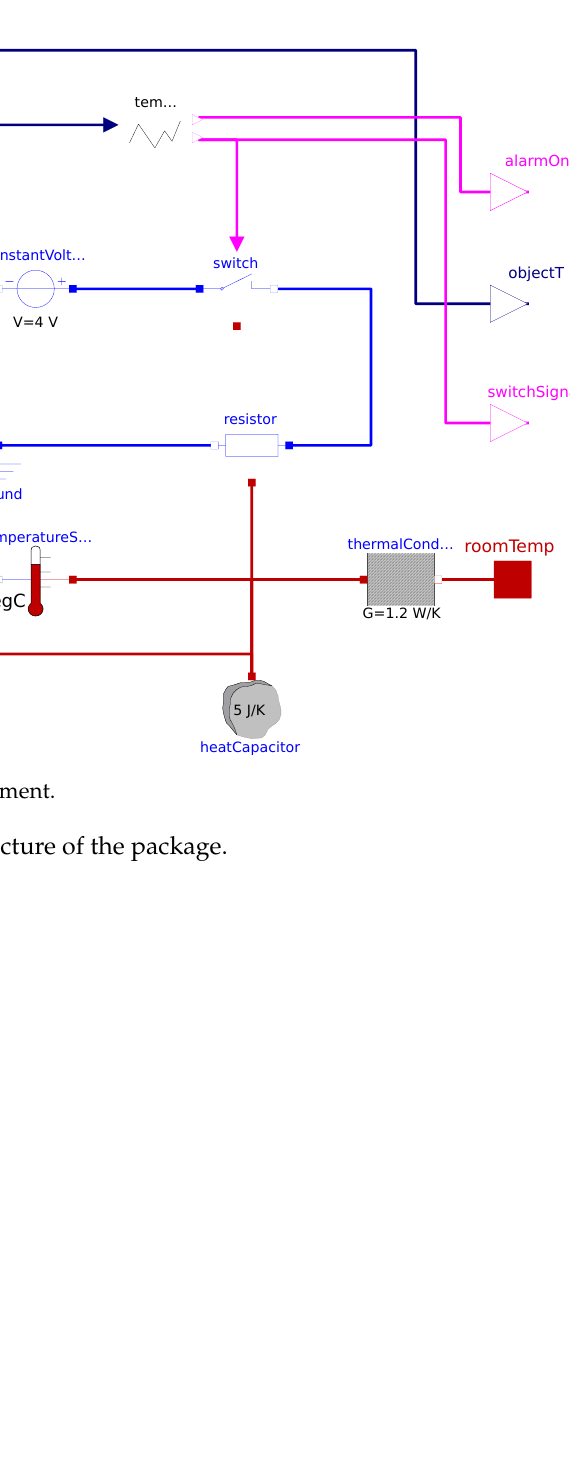
Figure 6. The contents of the HeatedExample